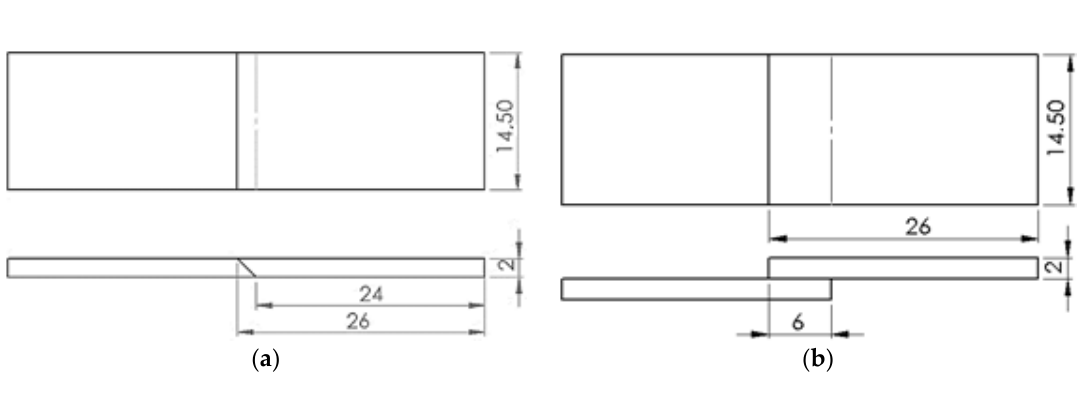
Figure 2. Dimensions of the types of joints welded and tested: ( a ) 45° scarf joint; ( b ) lap joint.